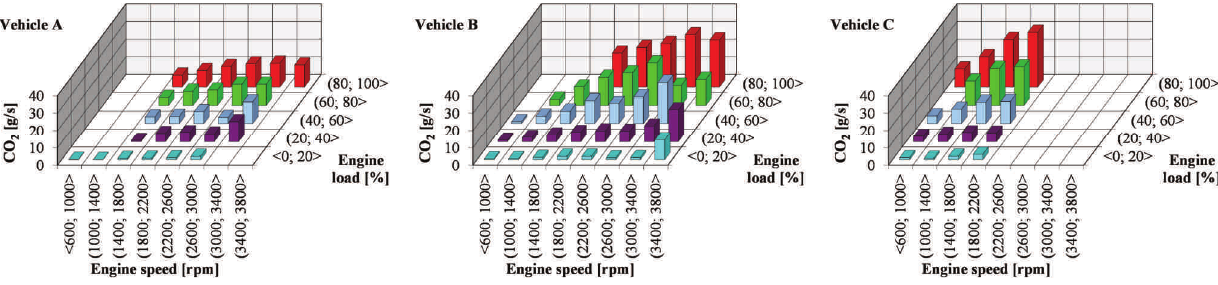
Fig. 6. CO 2 emissions concentration in the speed and torque compartments during road